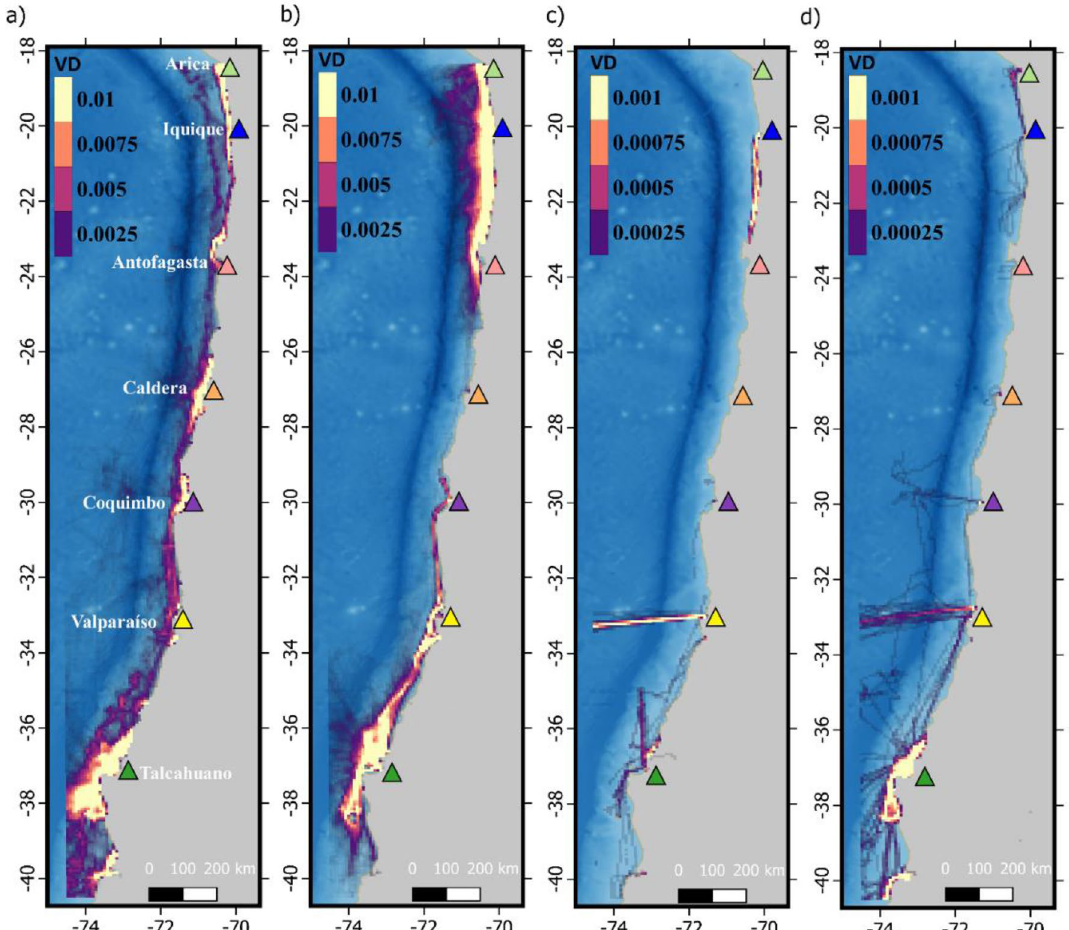
Figure 4. Vessel density (VD) as the mean number of vessels per km 2 per day, for the artisanal fishery ( a ), industrial fishery ( b ), transport ( c ) and aquaculture ( d ) fleets. Colored triangles indicate the location of most important ports. Data layers (including maps) were created in R ver. 4.0.2 (www.r- proje ct. org) and ensembled in QGIS ver. 3.8.0 (www. qgis. org) for final rendering. Maps were created using data on bedrock topography from the National Centers for Environmental Information (https:// maps. ngdc. noaa. gov/ viewe rs/ grid- extra ct/ index. html). Grid-cells with values above 0 were considered land coverage and assigned a uniform